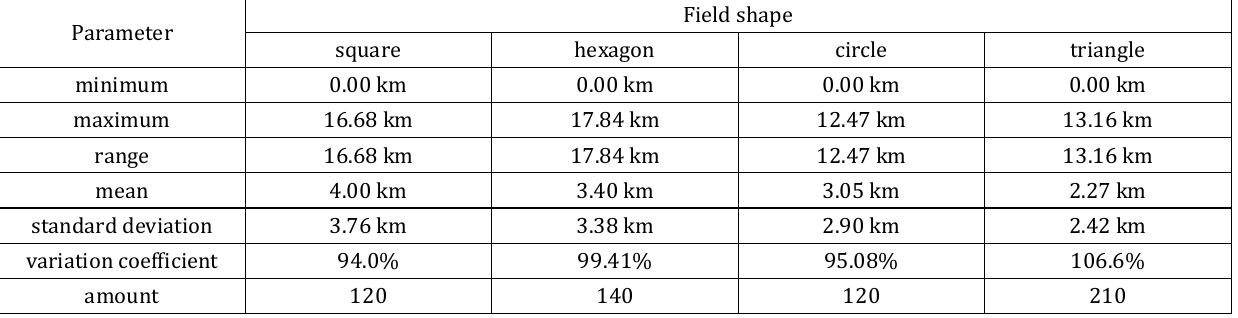
Table 5. Statistical data of basic fields (8